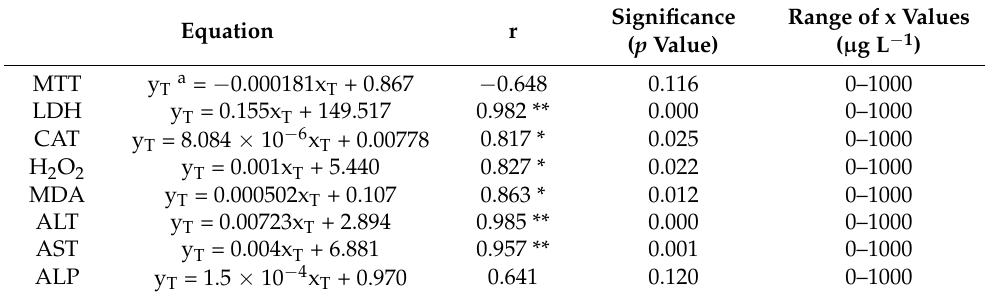
a y T, x T represent TC treatment. “*” indicates significant relationship at 5% level, “**” indicates significant relationship at 1% level ( n =